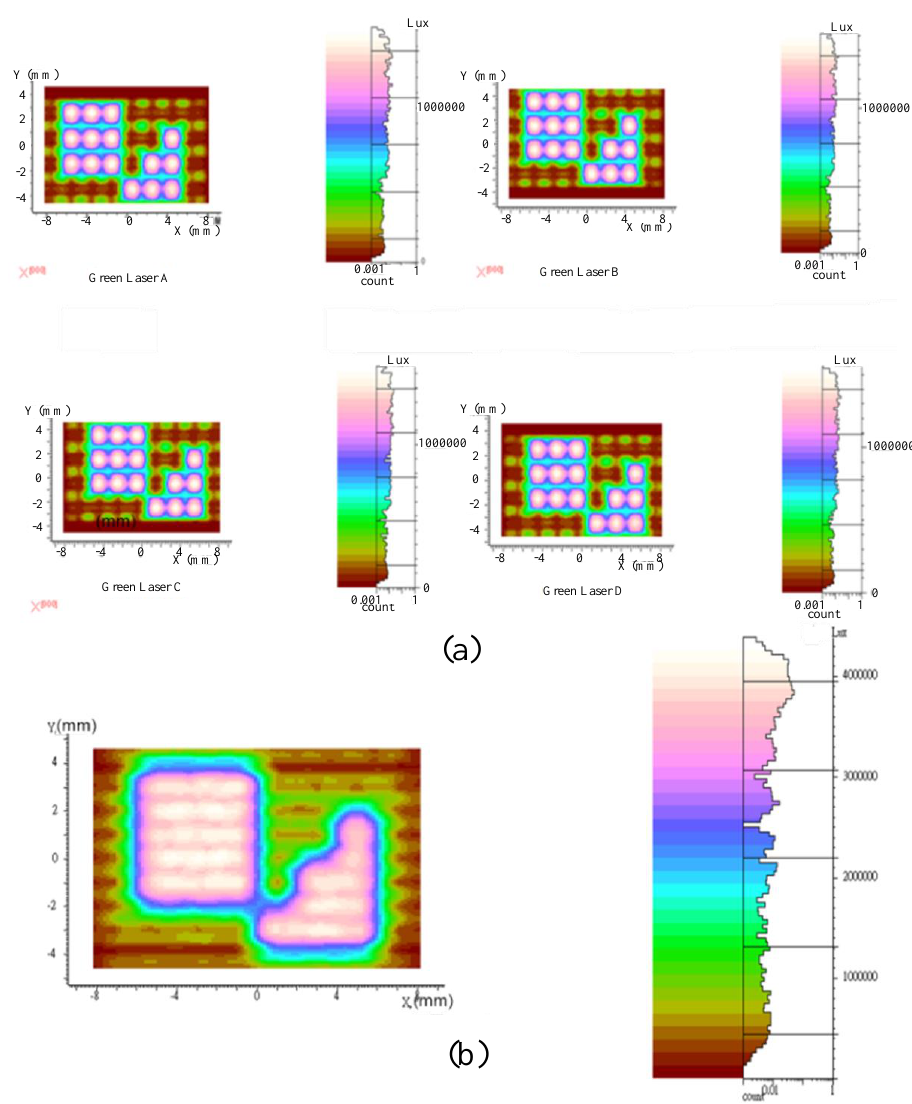
Figure 15. ( a ) Single green laser, displaying displacement map for local dimming (liquid crystal lens with pore size of 2.0 mm and a focal length of 23 cm). ( b ) Four green lasers, displaying compensation for light source micro scanning (liquid crystal lens with pore size of 2.0 mm and a focal length of 23 cm). Table 7. Contrast and light efficiency for a single red laser and cyclic micro-scanning laser (liquid crystal lens with pore size of 2.0 mm and a focal length of 23 cm).